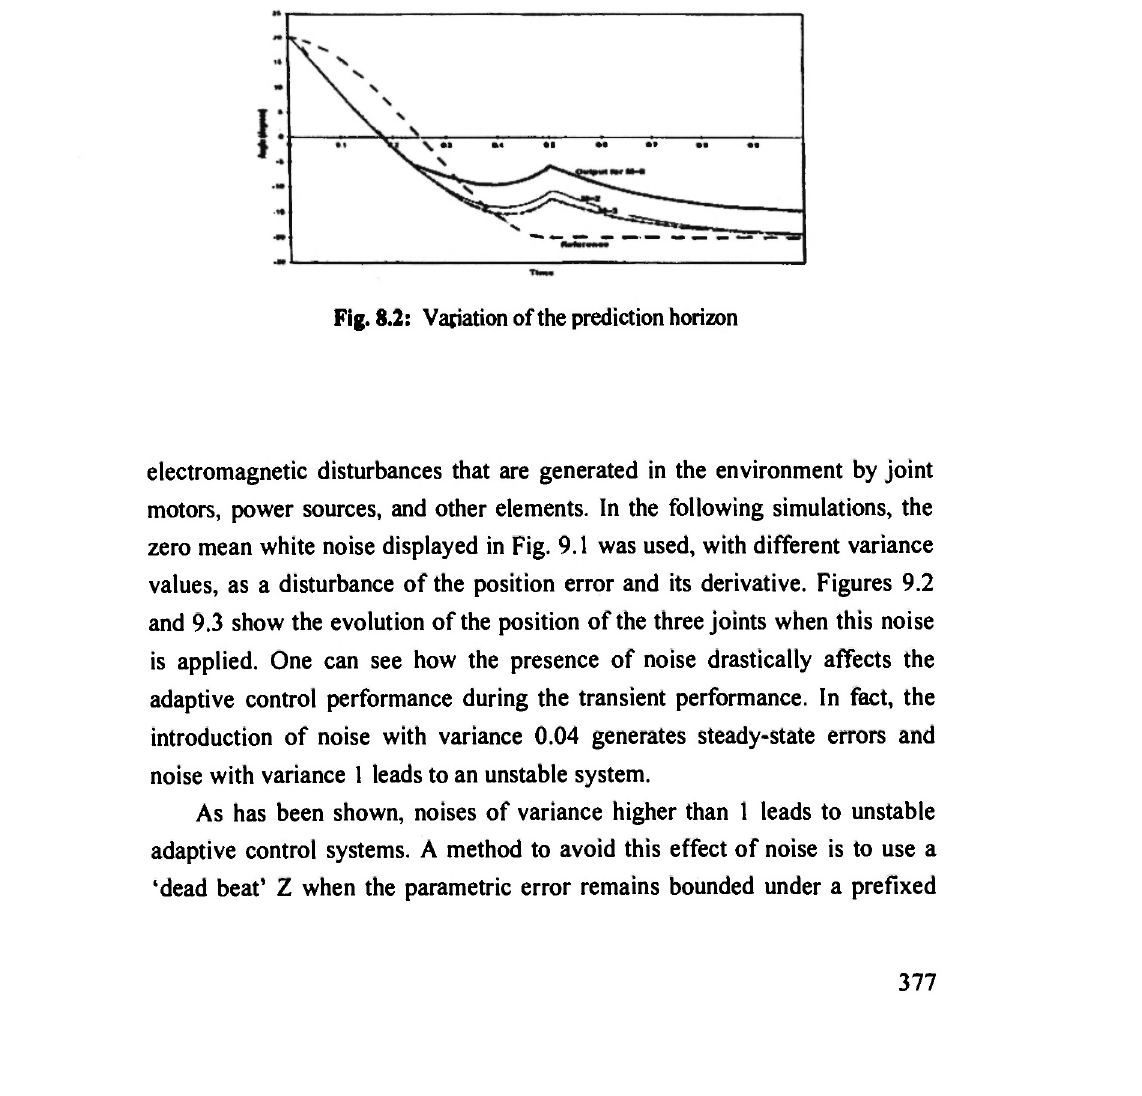
Fig. 8.1: Variation of the correction horizon